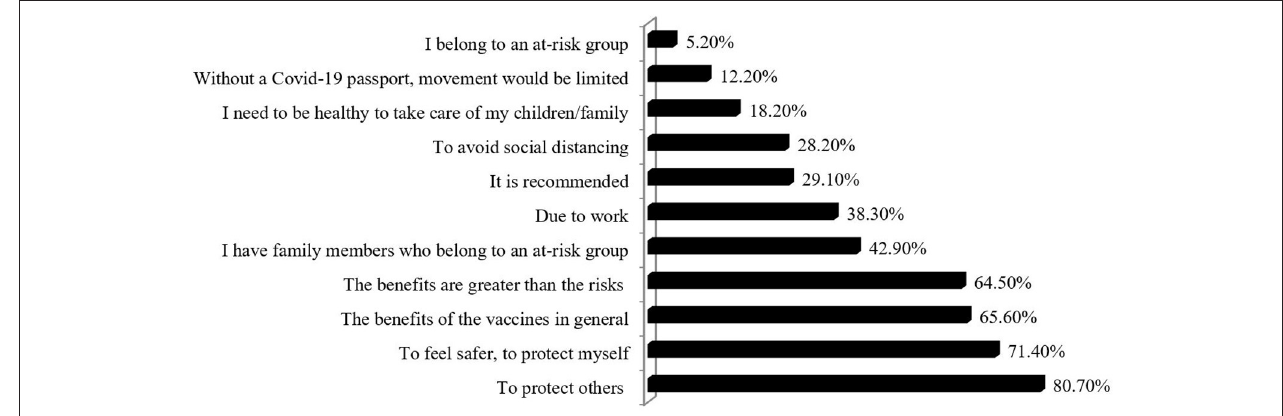
FIGURE 2 | Reasons provided for COVID-19 vaccine